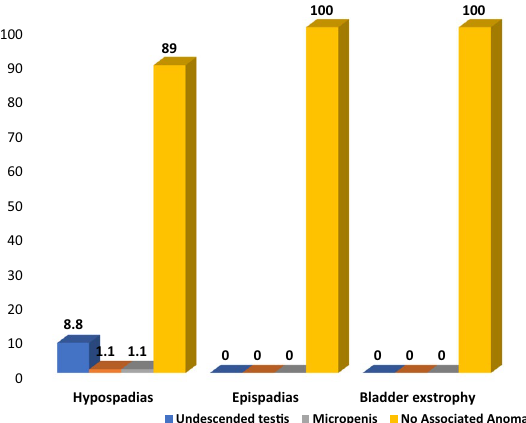
Fig. 4 Distribution of associated anomalies among clinically apparent urethral anomalies